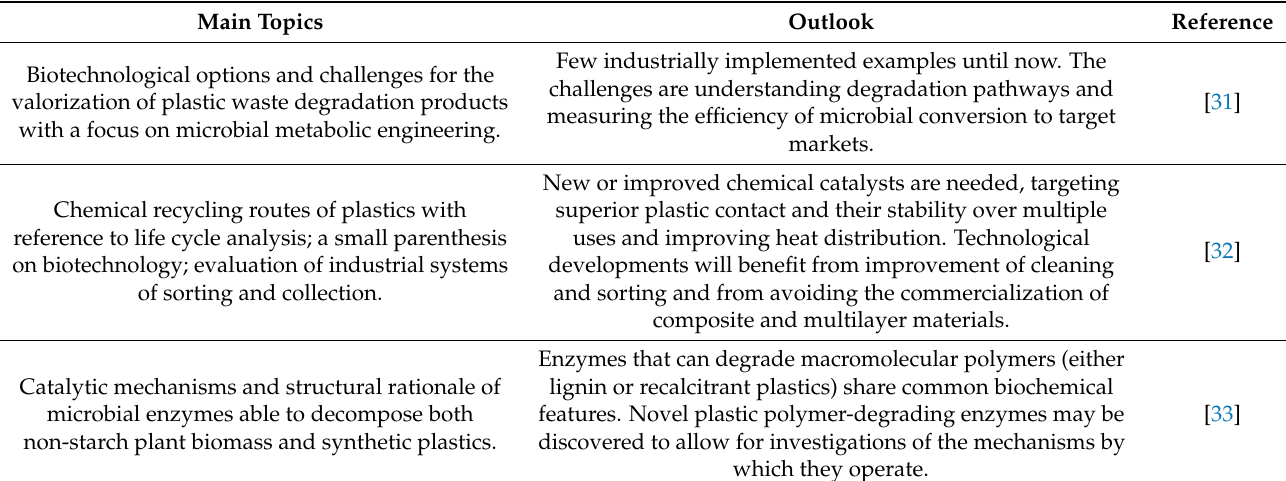
Table 1. List of recent and most relevant general reviews that include biotechnology-based degrada- tion and/or recycling of plastic waste (descending order from the oldest to the